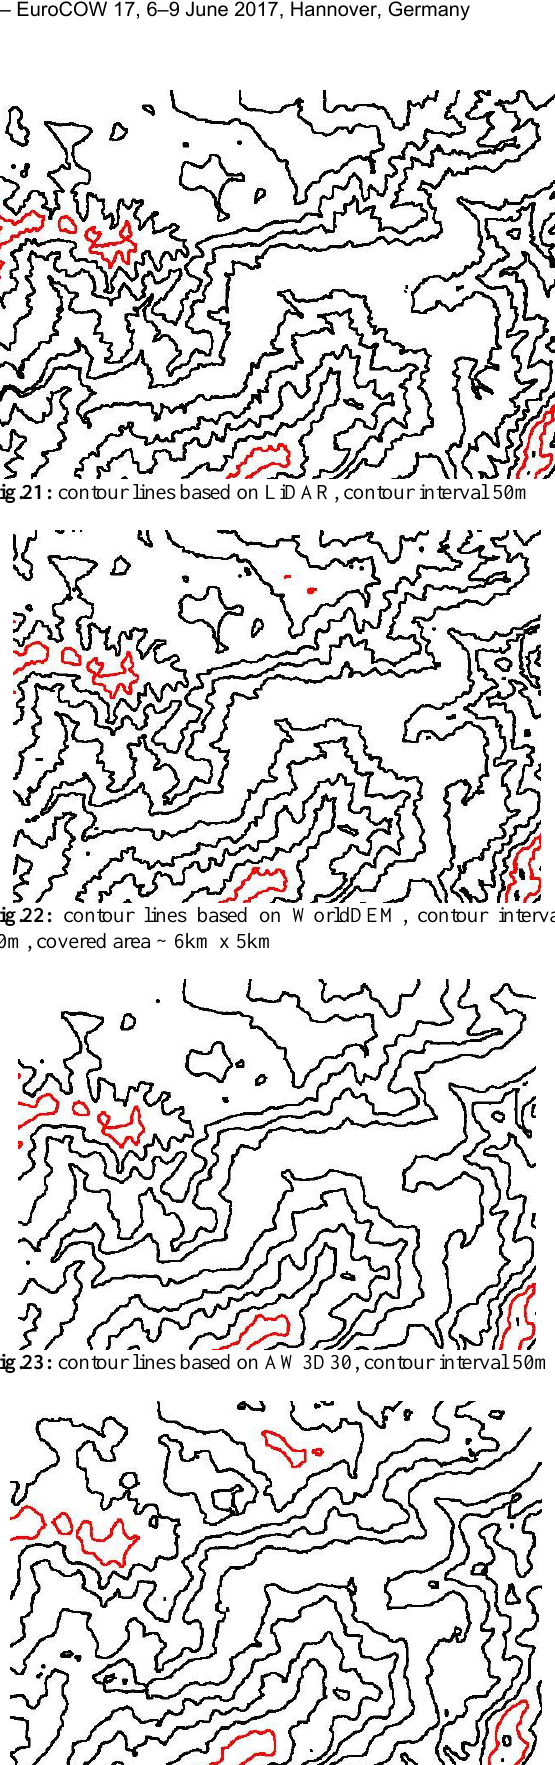
Fig. 24: Contour lines based on ASTER GDEM2, contour interval 50m, covered area ~ 6km x